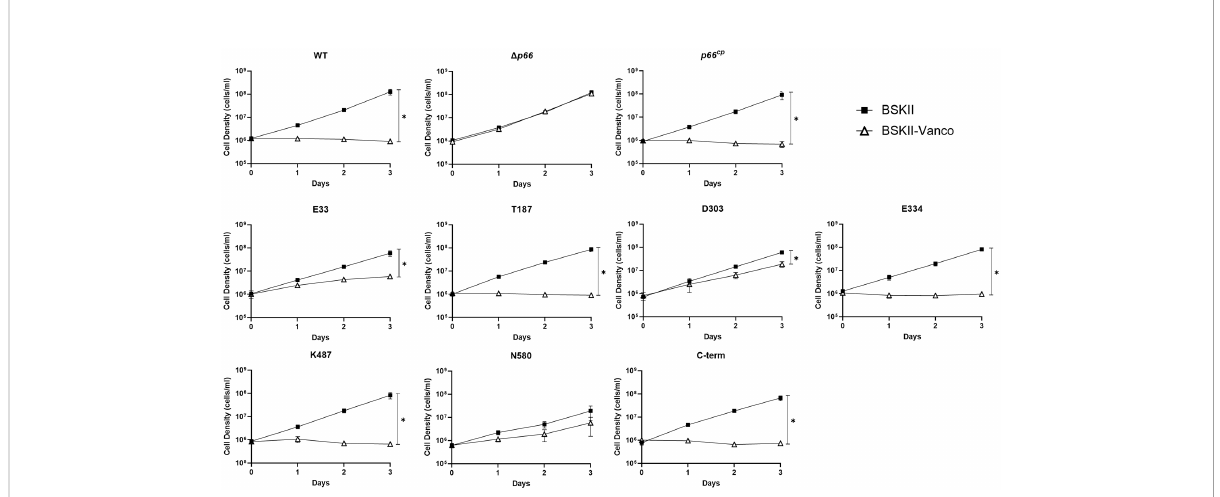
FIGURE 7 Vancomycin has differential effects on the growth of B . burgdorferi c-Myc P66 cp strains. B31 A3 WT, D p66 , and c-Myc P66 cp strains were grown to exponential phase, diluted to 1 x 10 6 cells ml -1 in BSKII and BSKII + vancomycin (1 m g ml -1 ) and incubated at 33°C. Cultures densities were determined daily. Data are presented as mean ± SEM of six replicates for WT, D p66 , p66 cp and three replicates for all the c-Myc P66 cp strains. Slopes were analyzed using linear regression (* = p<